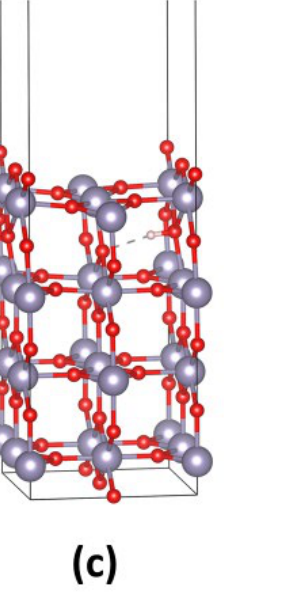
Figure 6. ( a ) The supercell, ( b ) the (110) surface model used, ( c ) the hydrogen interstitial in the (110) surface and ( d ) the bridge site adsorption on the (110) surface.